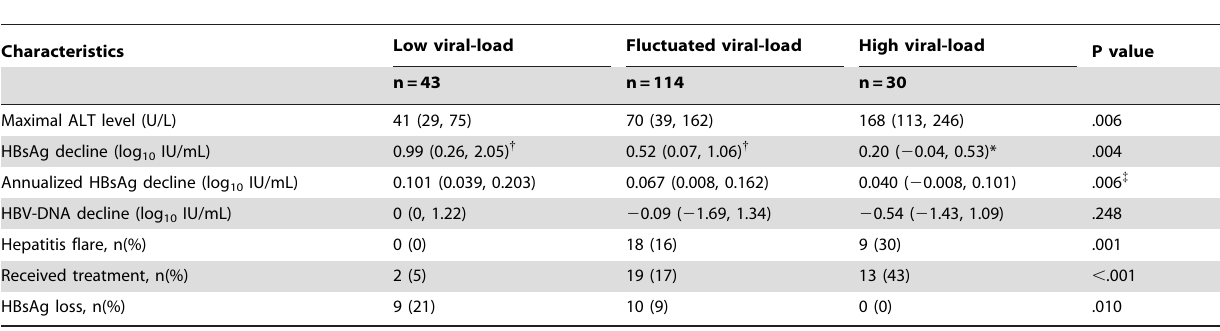
Table 2. Long-term events of groups according to their hepatitis activities.